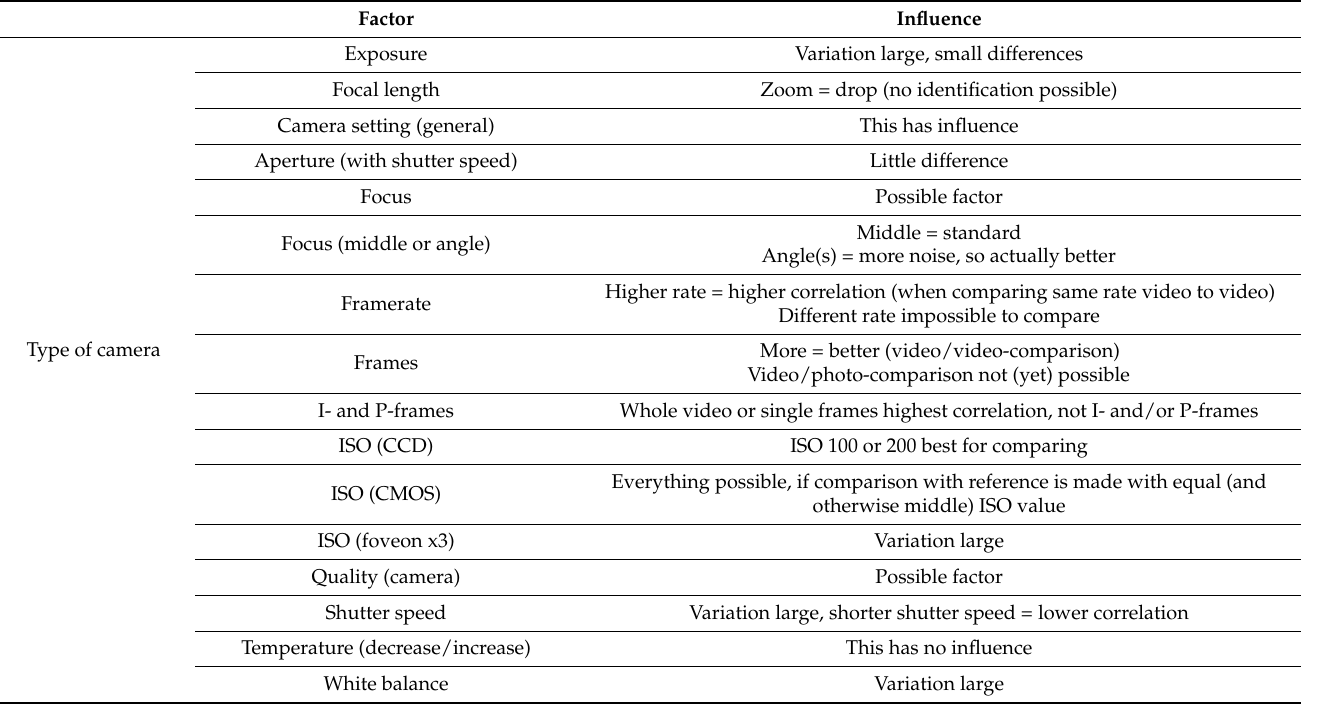
Table A1. Overview of possible factors that influence a decrease of the (PRNU) correlation value in videos (or images in